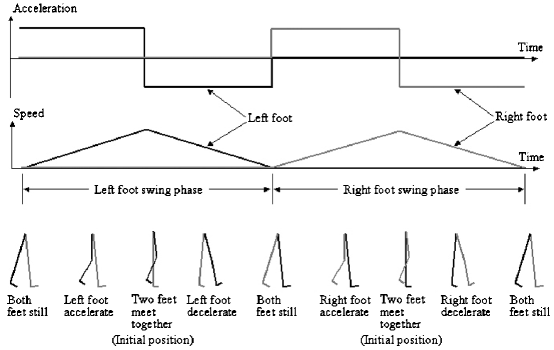
Fig. 3. Walking Model proposed by Zhao and Shibasaki, 2005